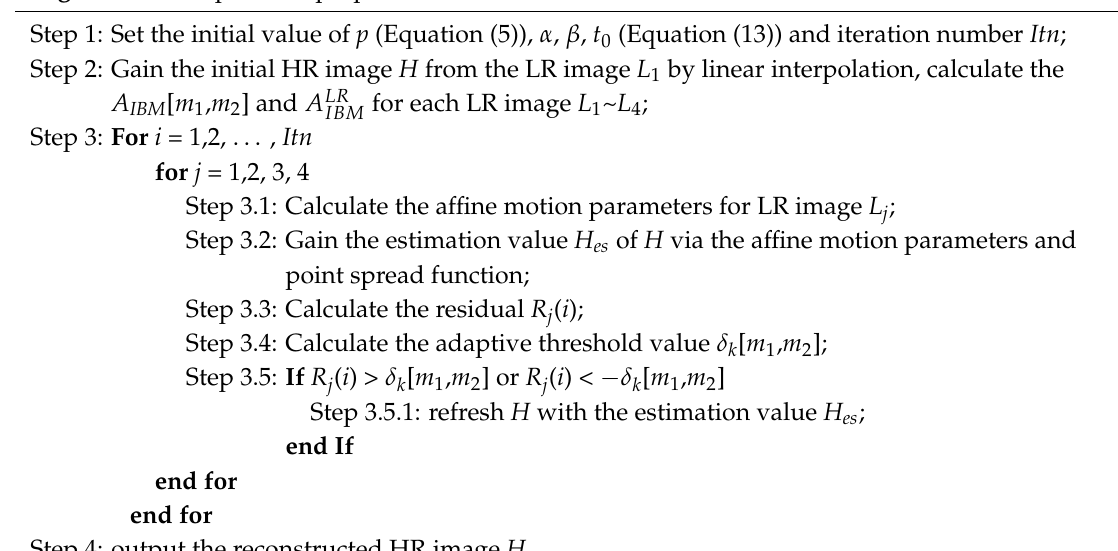
Algorithm 2. Steps of the proposed APOCS-BM